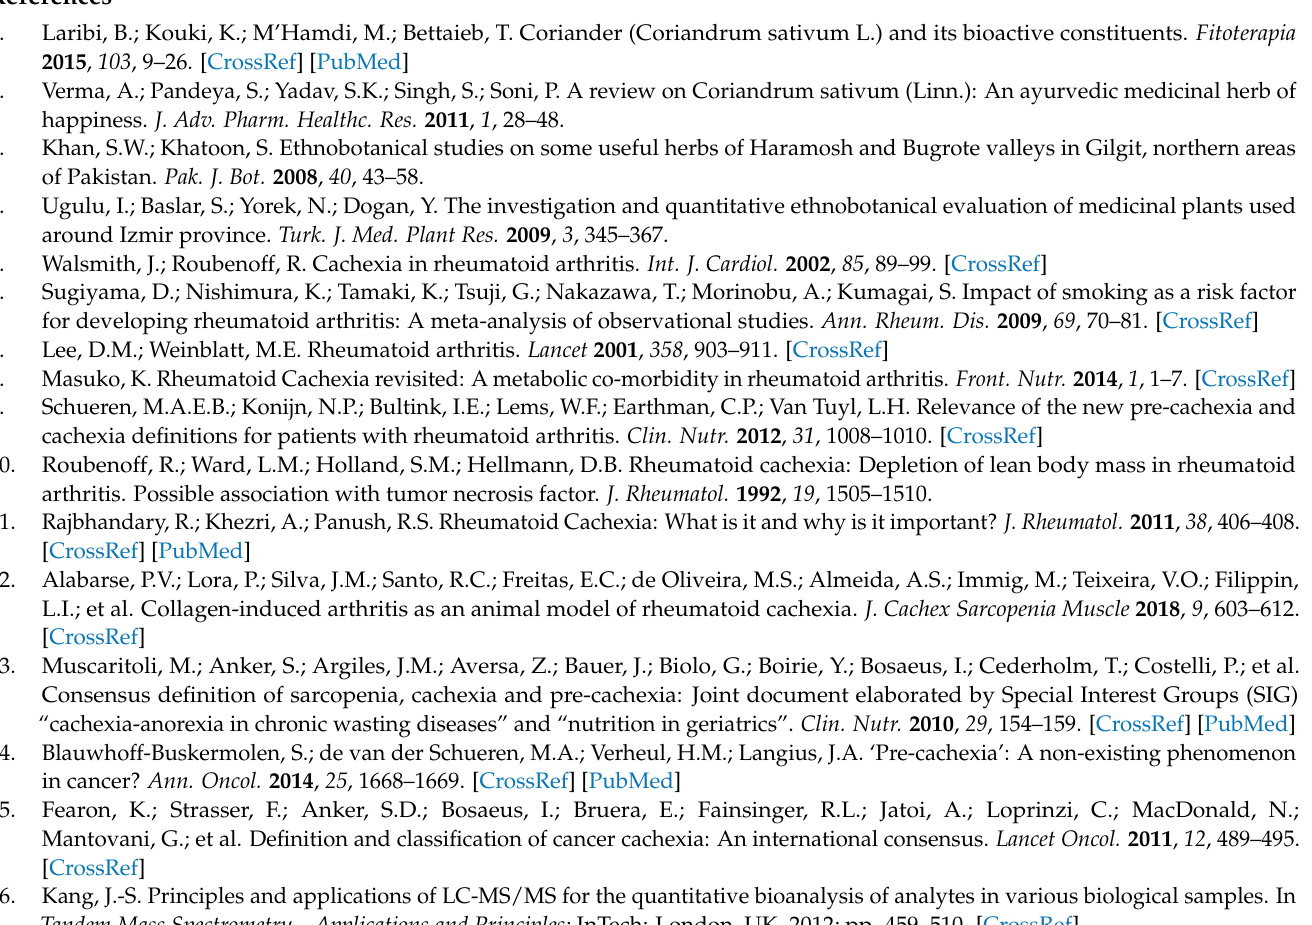
Figure S2: KEGG graph of glycolysis/gluconeogenesis with fold change information. Figure S3: KEGG graph of oxidative phosphorylation with fold change information. Table S1: Diet